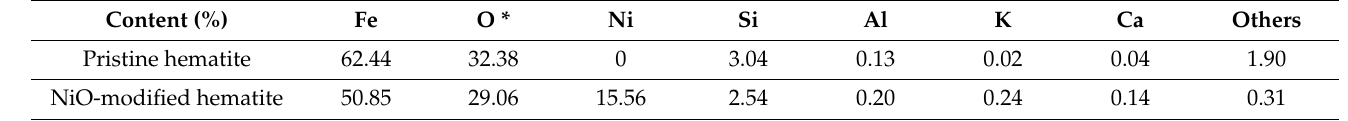
Table 2. The XRF analyses of the pristine hematite and the NiO-modified hematite